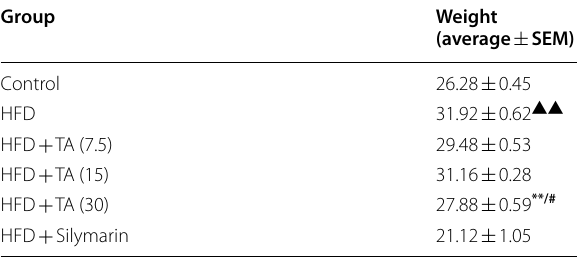
Note: BW was measured in g. Control: mice were fed a normal diet and treated with 0.5% CMC-Na (solvent) via gavage; HFD: mice were fed HFD; HFD HFD TA (15), and HFD TA (30): mice were fed HFD and treated with TA (7.5, + + 15, and 30 mg/kg, respectively) via gavage;